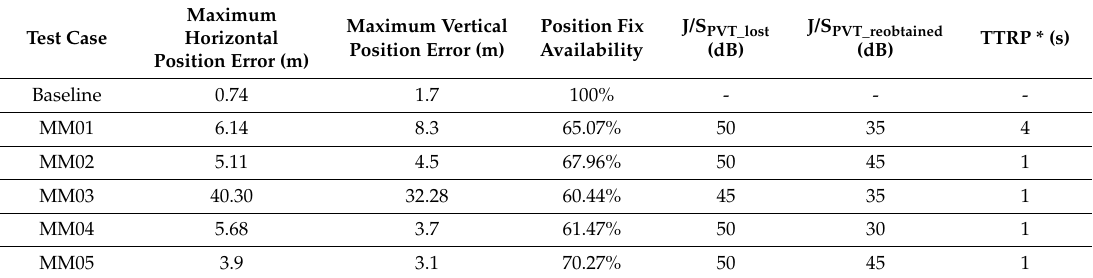
Table 4. Test results for MM